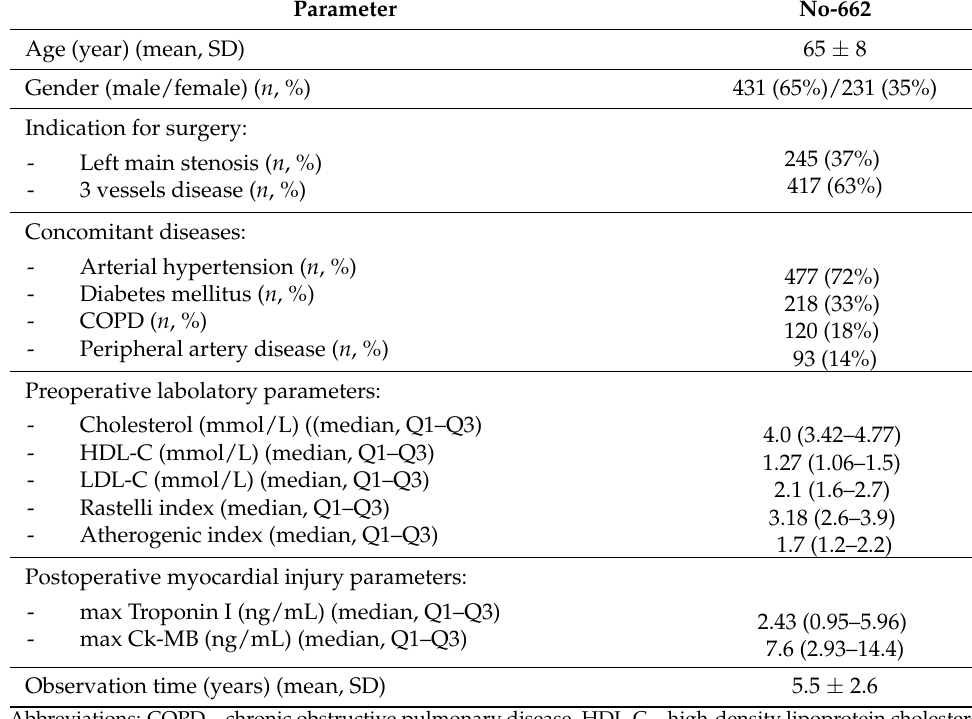
Table 1. Demographical and clinical